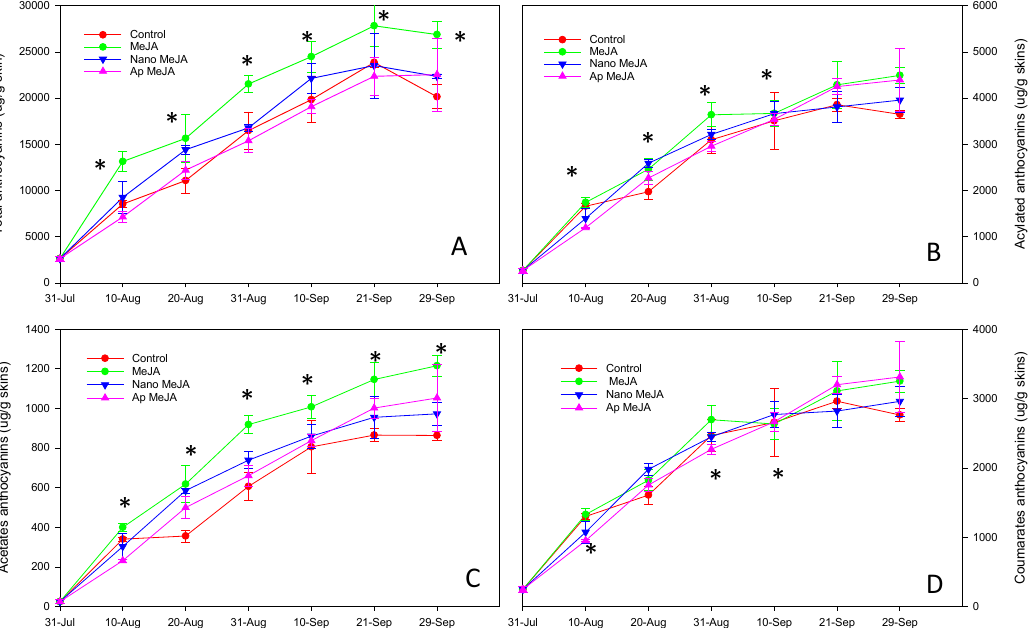
Figure 3. Anthocyanins in grapes during the ripening period. ( A : total anthocyanins; B : acylated anthocyanins; C : acetates anthocyanins; D : coumarates anthocyanins.) Abbreviations: MeJA: methyl jasmonate; Nano-MeJA: methyl jasmonate adsorbed on amorphous calcium phosphate; Ap-MeJA: methyl jasmonate adsorbed on crystalline apatite nanoparticles. * Indicates significant differences among treatments according to Duncan’s test ( p < 0.05).